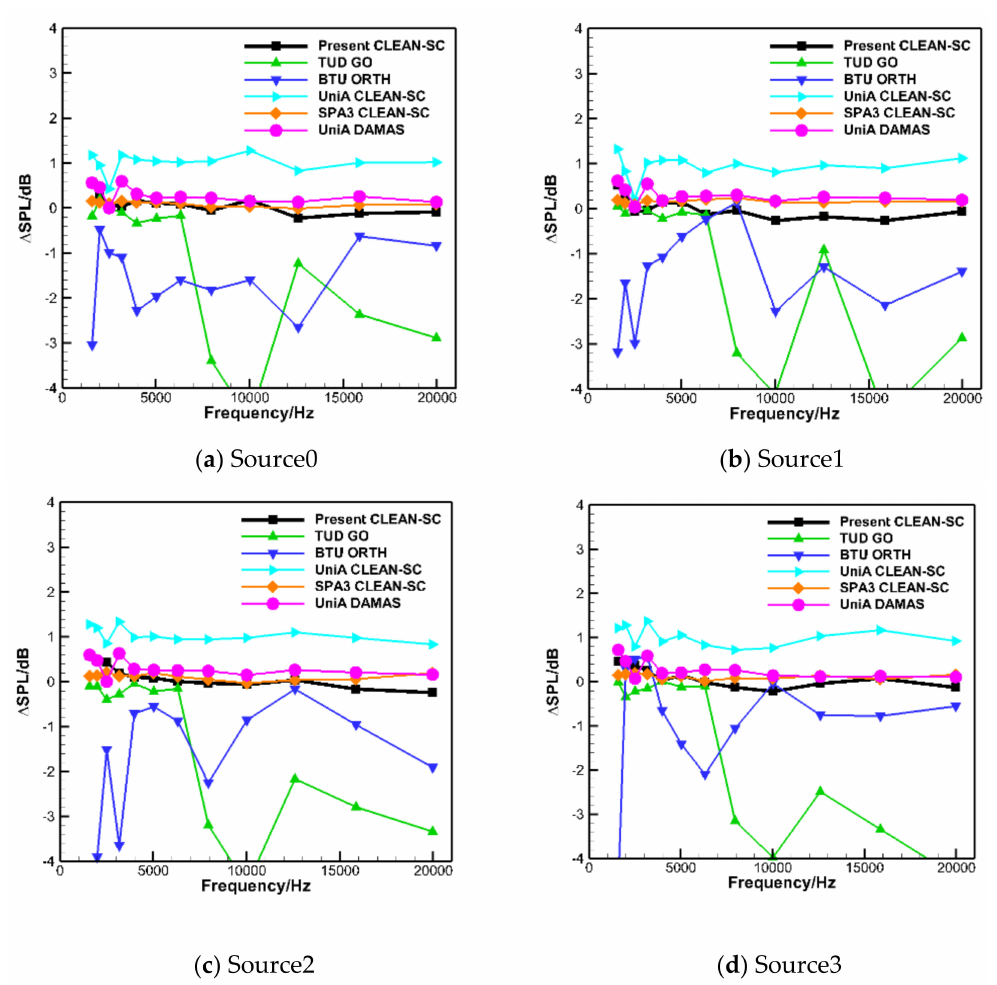
Figure 4. Comparison of the present results with other studies for subcase